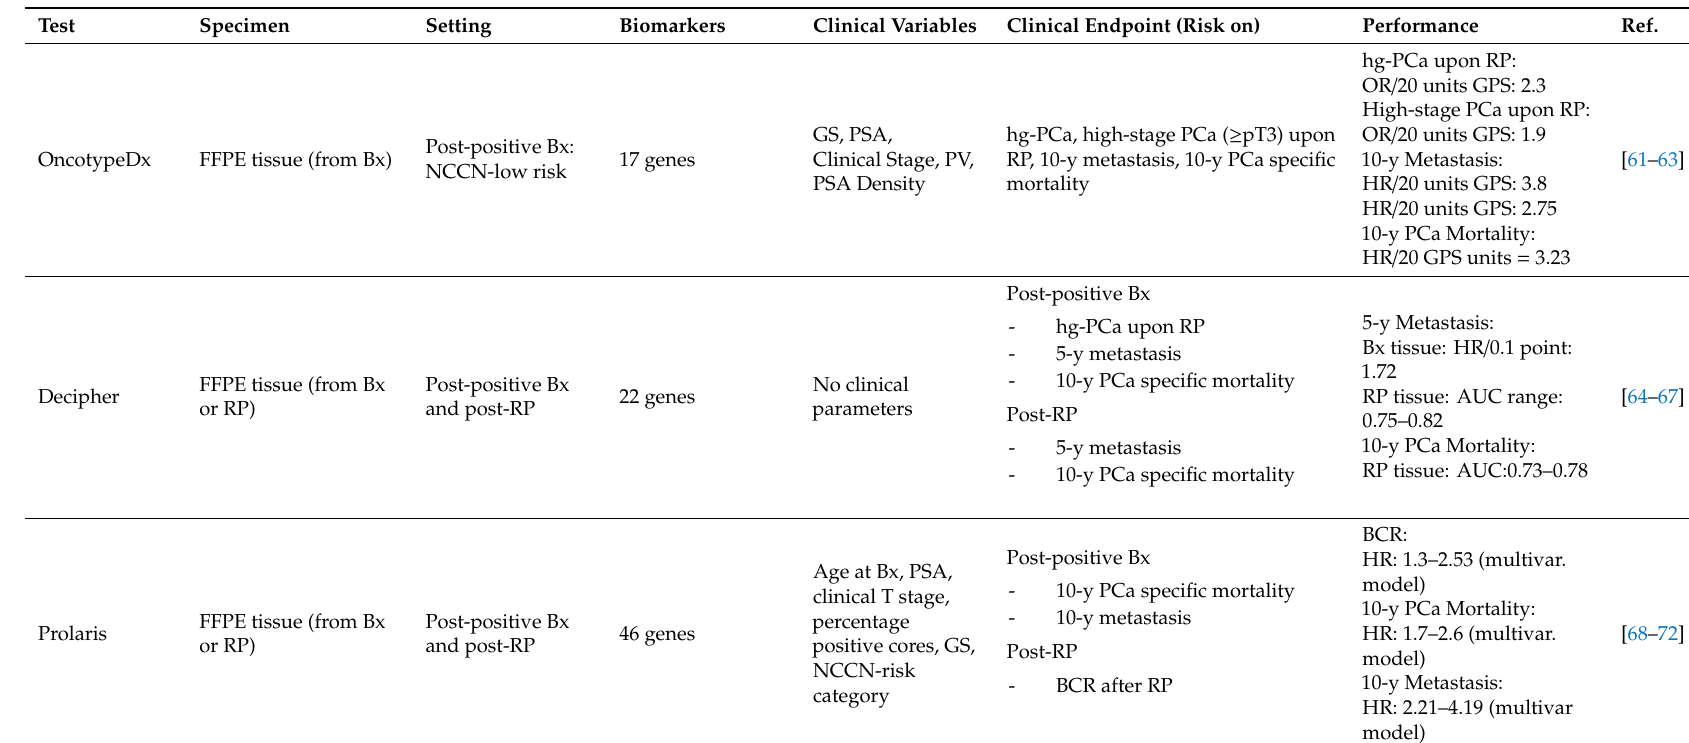
Table 2. Commercialized biomarker for PCa